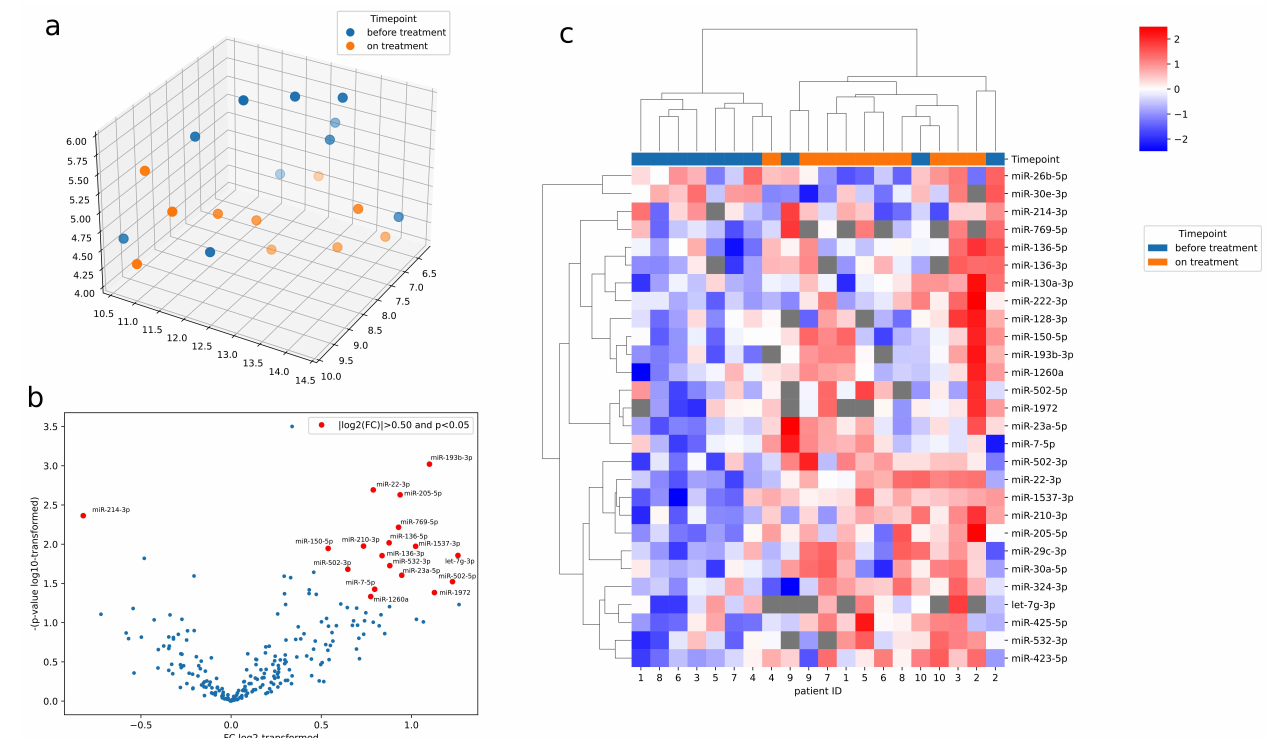
Figure 1. ( a ) UMAP representation of miRNA expression in samples before (blue) and after (orange) sirolimus treatment, missing data imputed with miRNA mean, minimal distance: 0.3, number of neighbors: 4, distance metric: Euclidean, miRNA filtration: expression in at least 5 pairs of samples, and FC calculated on paired samples only. ( b ) Paired comparison of miRNA expression before and after sirolimus treatment. ( c ) Heatmap of 28 significantly dysregulated miRNAs showing significant differences between groups: before (blue) and after (orange) sirolimus treatment ( p < 0.05 in paired t-test), normalized Cq values scaled in rows, linkage method: Ward, rows (miRNAs) distance: correlation, and columns (samples) distance: Euclidean.